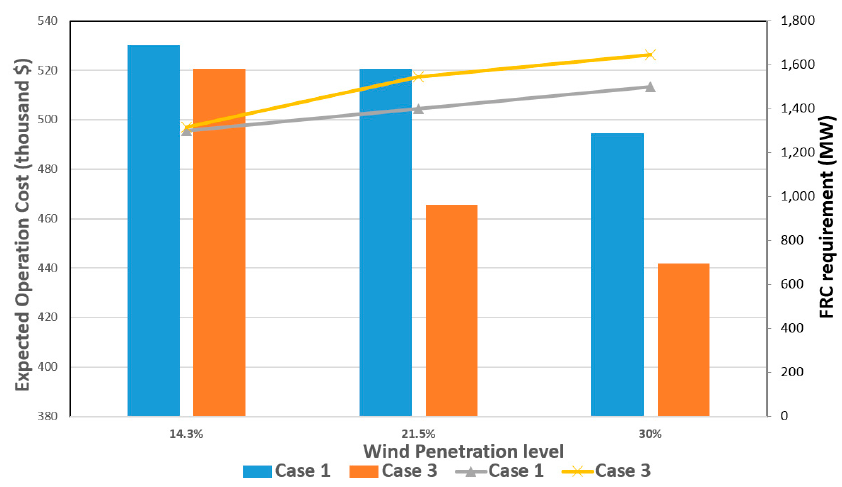
Figure 10. Expected operating costs and system RC requirements as a function of the wind generation level.